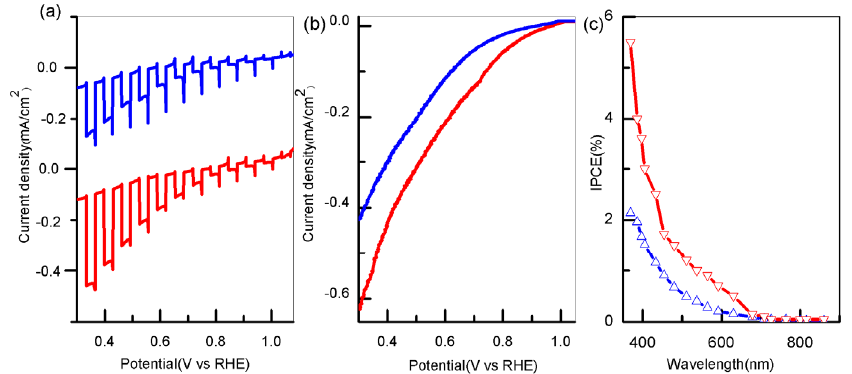
Figure 5. ( a ) Chopped photocurrent vs. voltage curves; ( b ) photocurrent vs. voltage (J–V) curves; ( c ) IPCE spectrum(blue and red lines represent before and after depositing Pt).